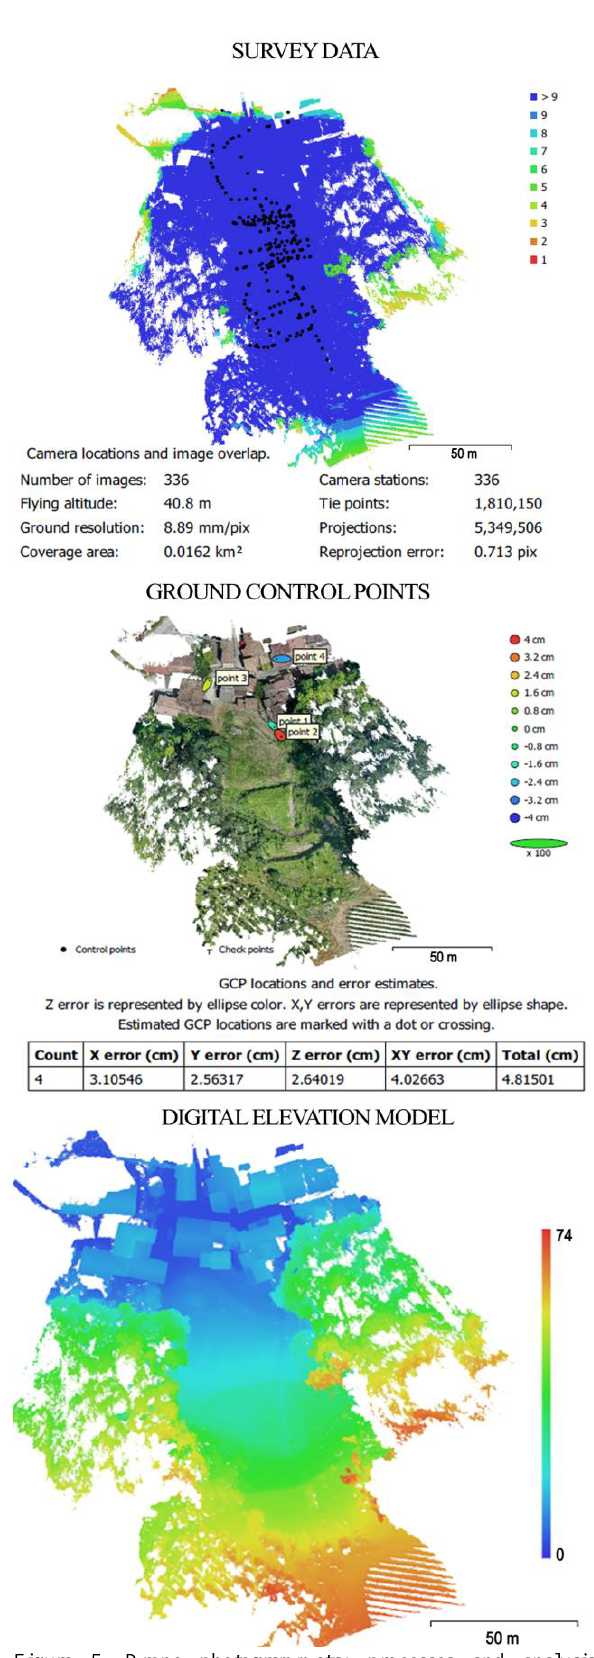
Figure 5. Drone photogrammetry processes and analysis concerning the first case